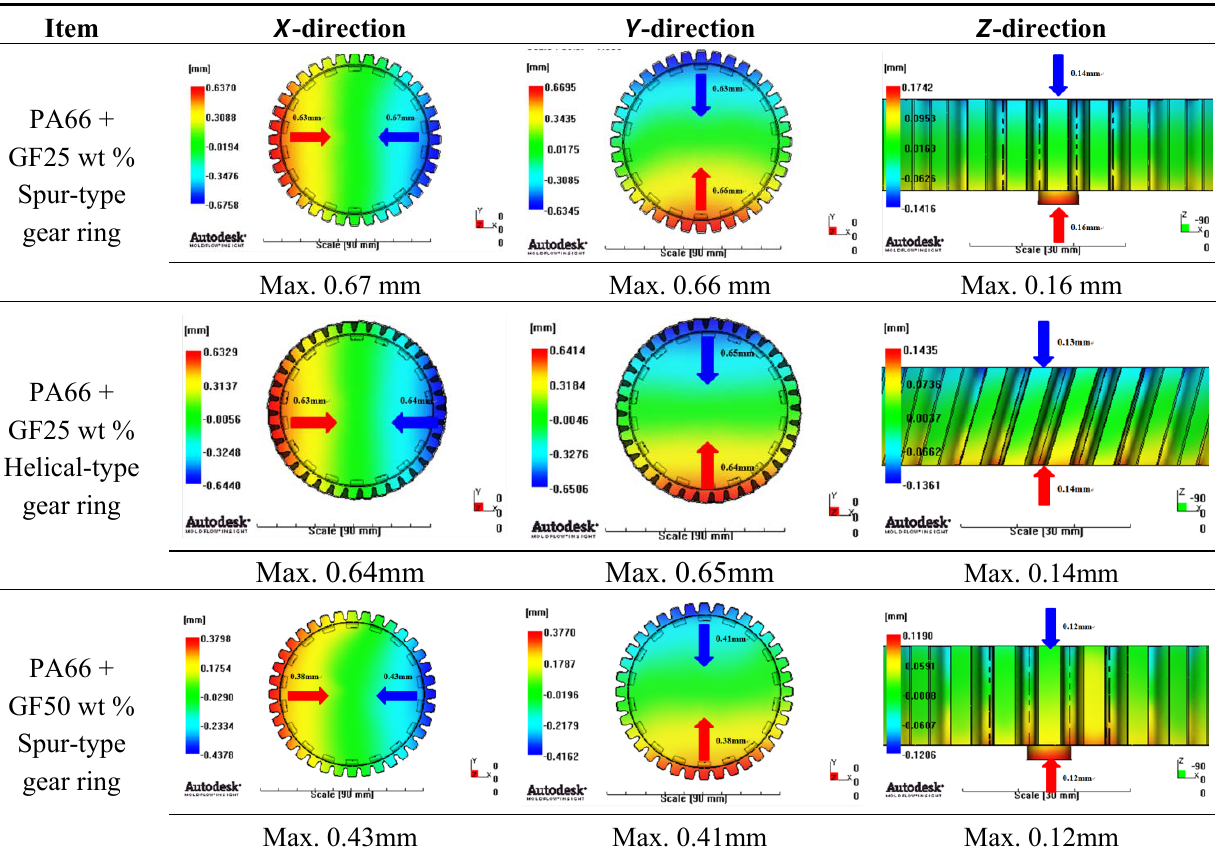
Table 6. Deformation values of X -, Y -, and Z